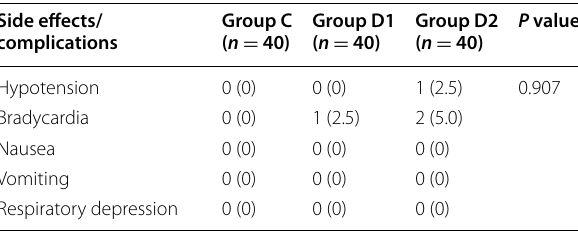
Table 2 Incidence of side effects or complications among three